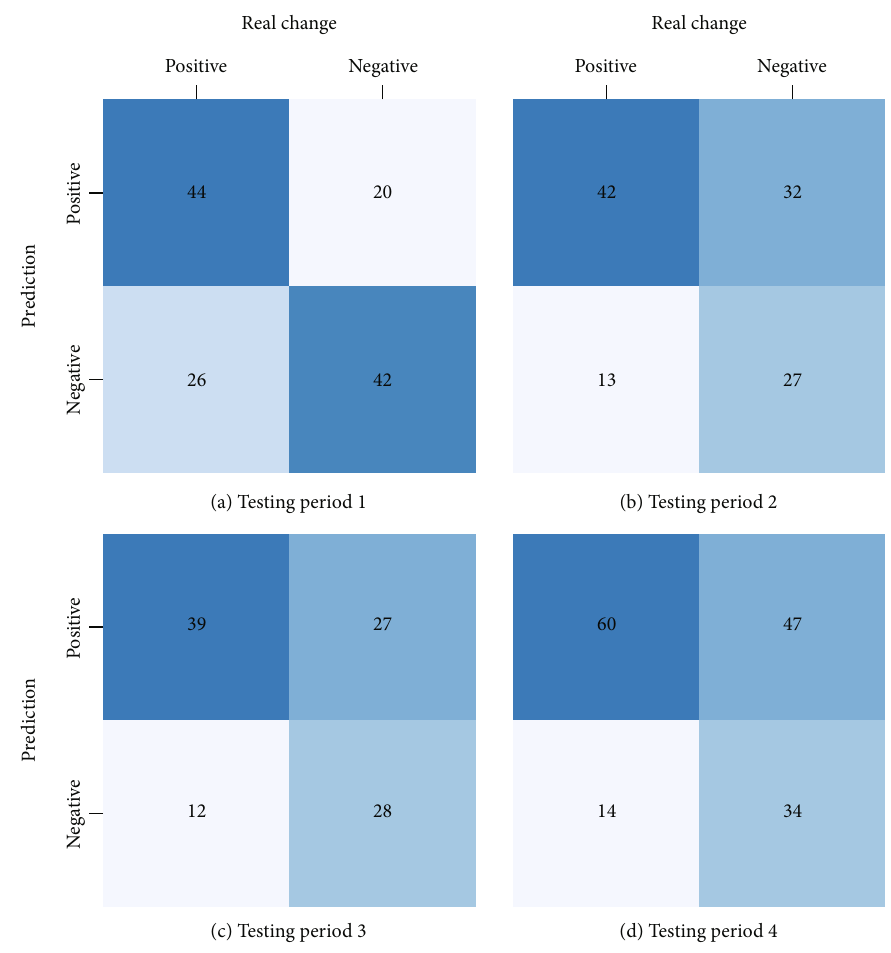
Figure 3: The confusion matrix results of direction prediction for the proposed method in the four testing periods. Table 6: The F1-measure results of the benchmarks and the proposed method SMOTE-FRS.